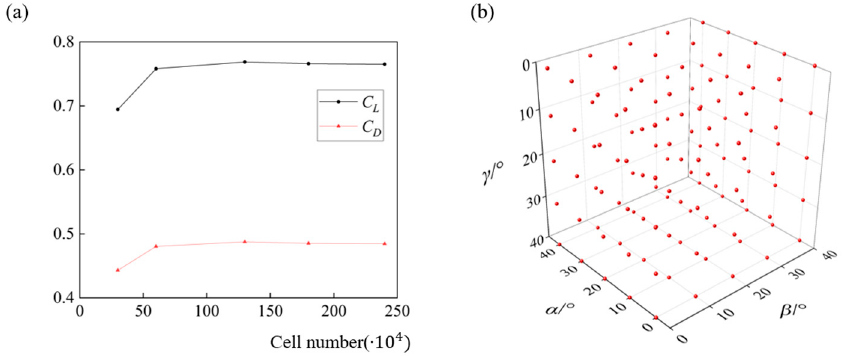
Figure 2. The mesh validation and sampling pool: ( a ) effects of cell number on the lift and drag coefficients of the ski and ( b ) distribution of 125 sample points to establish the Kriging models.